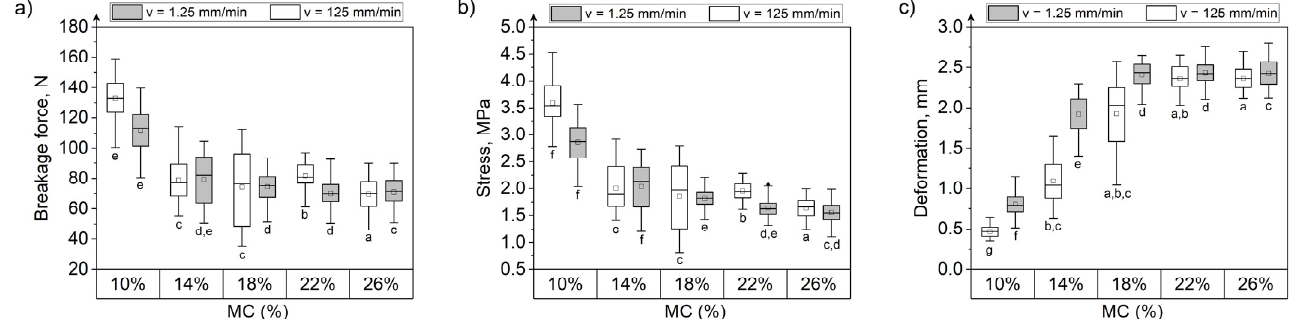
12 of 22 Figure 11. The breakage force ( a ), stress ( b ), and deformation ( c ) during soybean compression for Figure 11. The breakage force ( a ), stress ( b ), and deformation ( c ) during soybean compression for Figure 11. The breakage force ( a ), stress ( b ), and deformation ( c ) during soybean compression for five levels of moisture content and two loading rates. Letters below the box charts are the Figure 10. The breakage force ( a ), stress ( b ), and deformation ( c ) during rice grain compression for five levels of moisture content and two loading rates. Letters below the box charts are the interaction five levels of moisture content and two loading rates. Letters below the box charts are the Figure 11. The breakage force ( a ), stress ( b ), and deformation ( c ) during soybean compression for interaction grouping letters from the post hoc Fisher least significant difference means comparison five levels of moisture content and two loading rates. Letters below the box charts are the grouping letters from the post hoc Fisher least significant difference means comparison test. Means interaction grouping letters from the post hoc Fisher least significant difference means comparison interaction grouping letters from the post hoc Fisher least significant difference means comparison five levels of moisture content and two loading rates. Letters below the box charts are the test. Means that do not share a le tt er are signi fi cantly di ff erent. □ —mean, ── —median,  — interaction grouping letters from the post hoc Fisher least significant difference means comparison test. Means th at do not share a letter are significantly different. □— mean, ── — median, ◆ — that do not share a letter are significantly different. (cid:3) —mean, —— —median, test. Means that do not share a le tt er are signi fi cantly di ff erent. □ —mean, ── —median,  — interaction grouping letters from the post hoc Fisher least significant difference means comparison outliers. test. Means that do not share a letter are significantly different. □— mean, ── — median, ◆ — outliers. outliers. test. Means that do not share a letter are significantly different. □— mean, ── — median, ◆ — outliers. outliers.